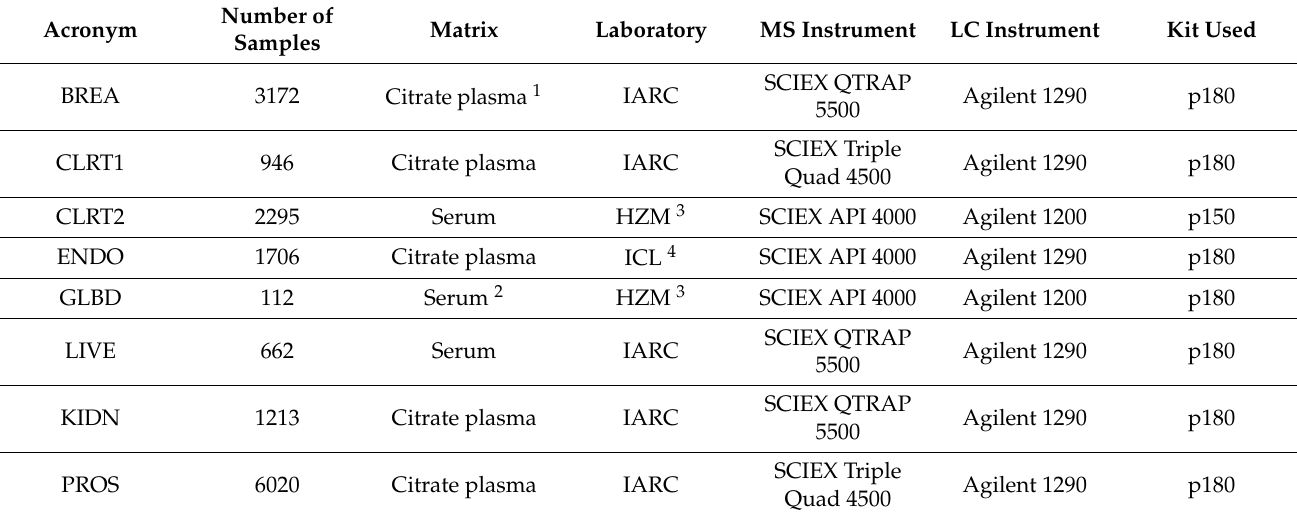
Table 1. Main characteristics of the study